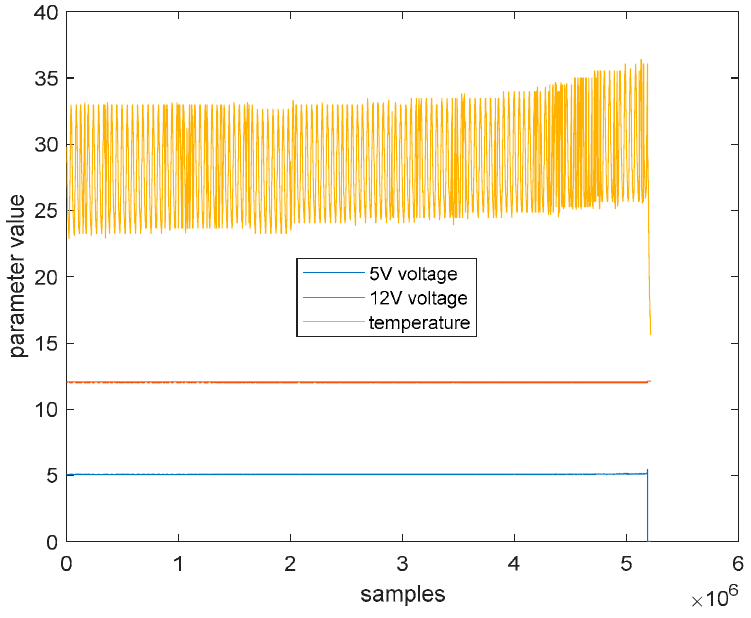
Figure 11. Raw telemetry data of the spread spectrum transponder. In this article, the satellite orbital period was used as the length of the sliding